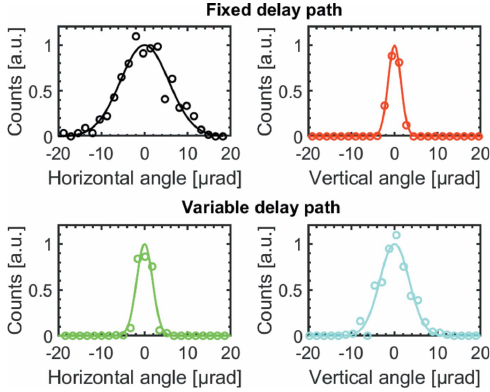
Figure 11 Pointing stability of both Ni-coated beam paths in the horizontal and vertical axis. In the fixed delay path a pointing stability of (cid:6) u f,horizontal = 6.5 m rad (FWHM) and (cid:6) u f,vertical = 2.8 m rad (FWHM) was measured. For the variable delay path it amounts to (cid:6) u v,horizontal = 4.3 m rad (FWHM) and (cid:6) u v,vertical = 9.7 m rad